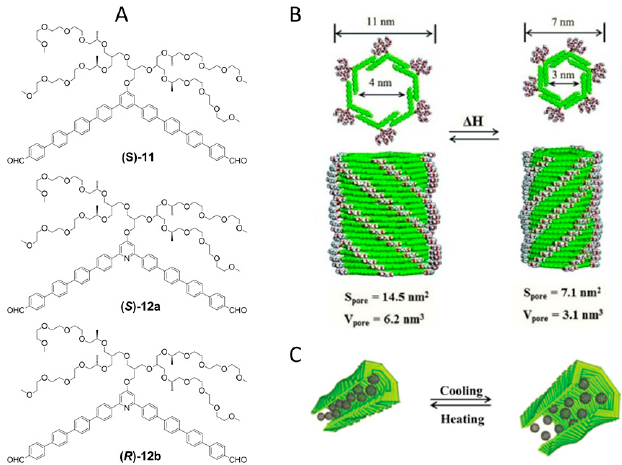
Figure 10. ( A ) Building blocks used in self-assembly of noncovalent NTs; ( B ) NTs section formed from 12a with reversible dilatation-contraction in function of thermal response; and ( C ) stimuli response on NTs in function of the temperature in sensing of C 60 . Reproduced with permission from Ref. [50] (Copyright the American Association for the Advancement of Science,